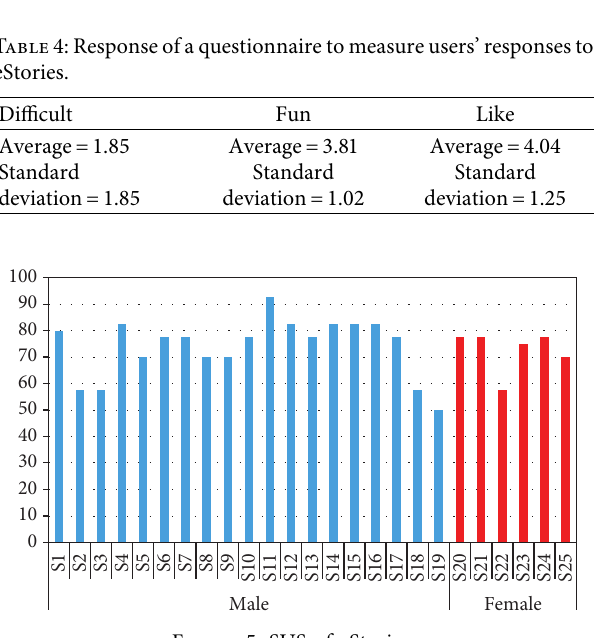
Figure 5: SUS of eStories.